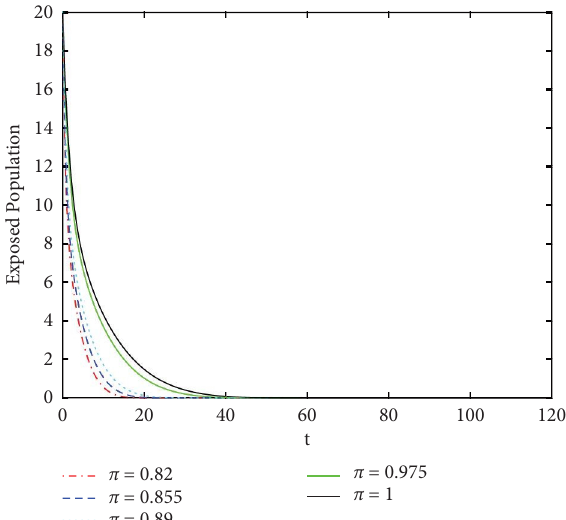
Figure 9: Te dynamics of exposed human population for various fractional orders υ and for fractal order π � 0 . 5.